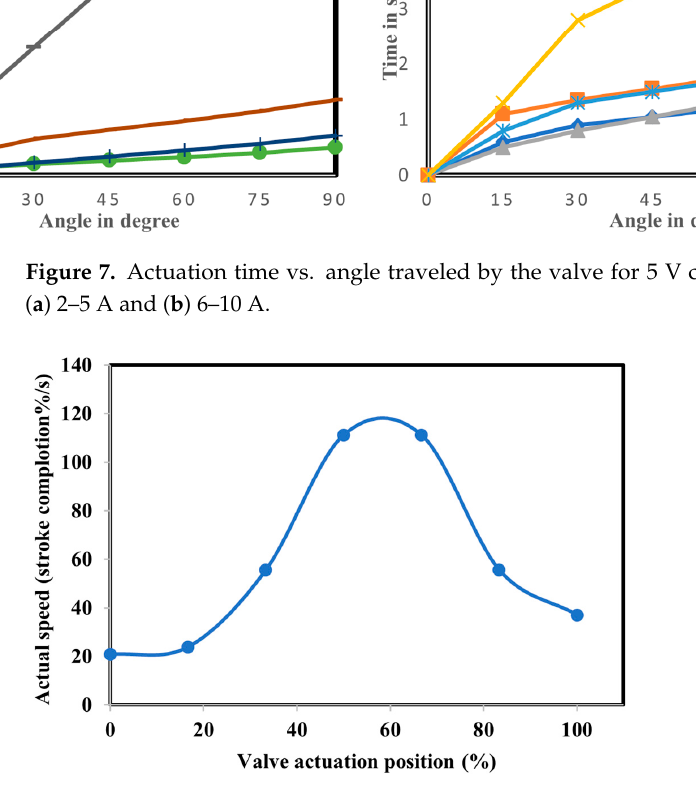
Figure 8. Actuator response stroke rate as a function of valve position for the 10 A current.